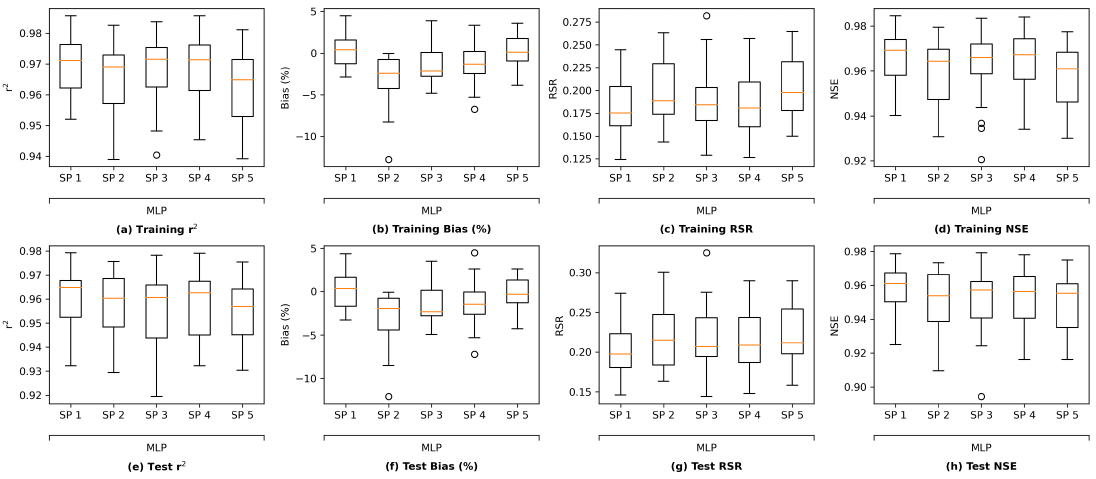
Figure A6. Comparison of the 5-fold cross-validation on the MLP architecture using observed data. “SP” stands for “split”.